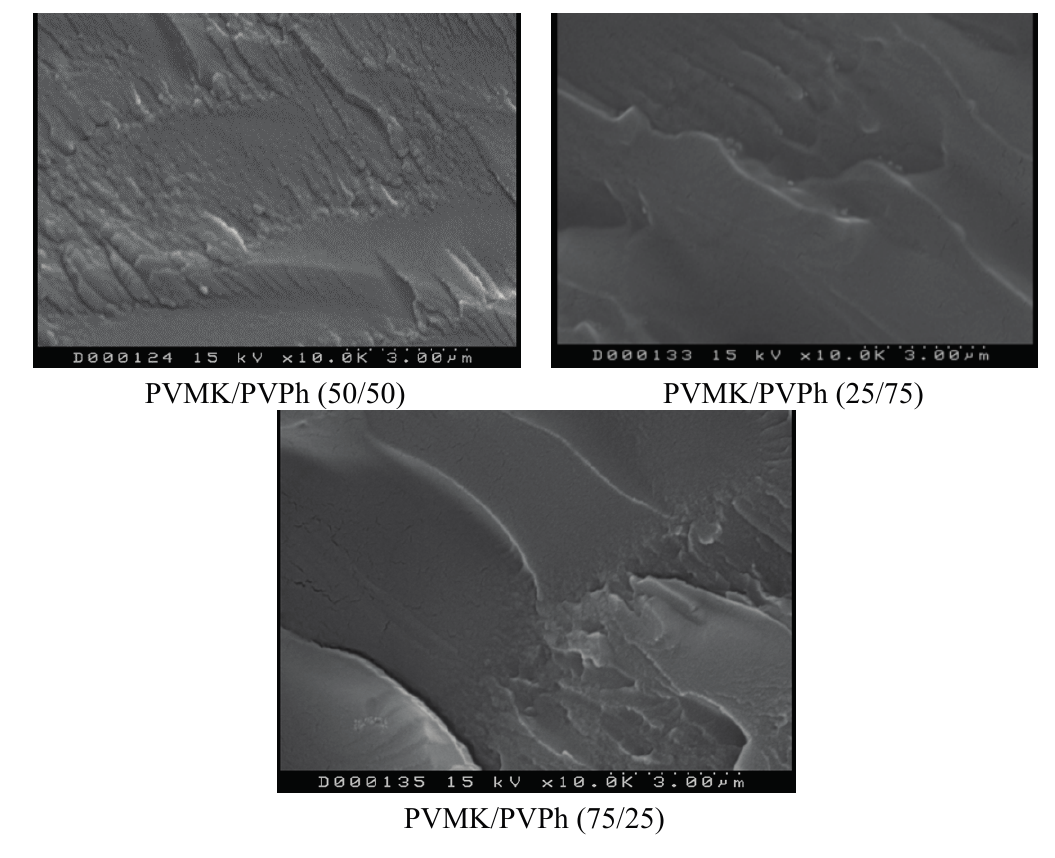
Figure 7. SEM photomicrographs of PVMK/PVPh blends in three different ratios (75/25, 50/50,